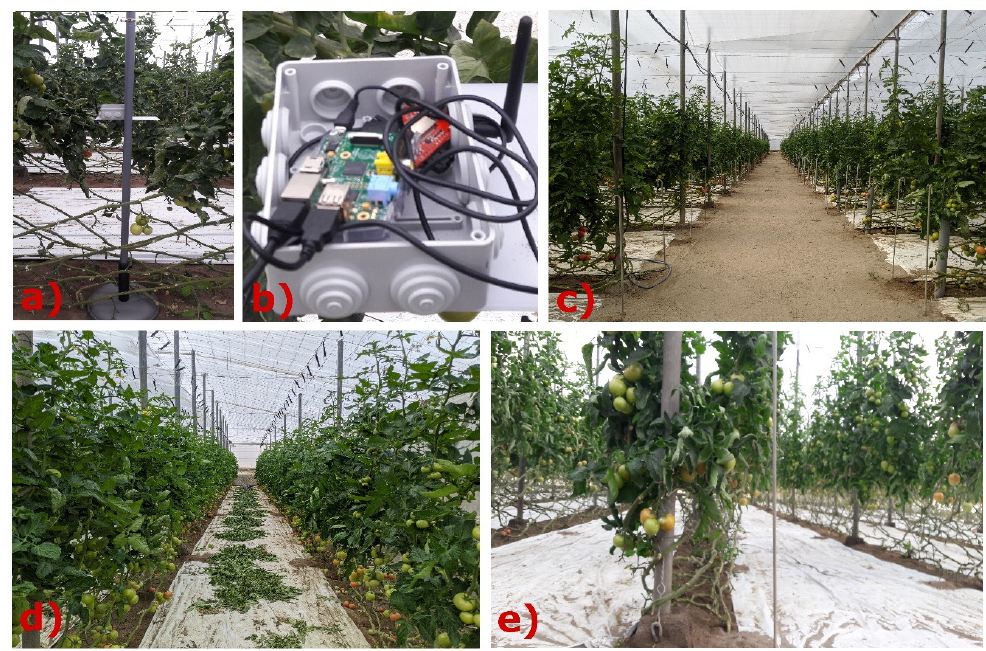
Figure 1. Images of the greenhouse. ( a ) Remote node that sends the signal to the sink node (Tx).( b ) Equipment used by RSSI measurement system in the receiver - RX (Re-Mote connected with USB cable to the Raspberry Pi 3) (c) Main aisle ( d ) Side aisle between two “tomato plant walls” ( e ) View of the thickness of the “tomato plant walls”. Sensors 2020 , 20 , x FOR PEER REVIEW